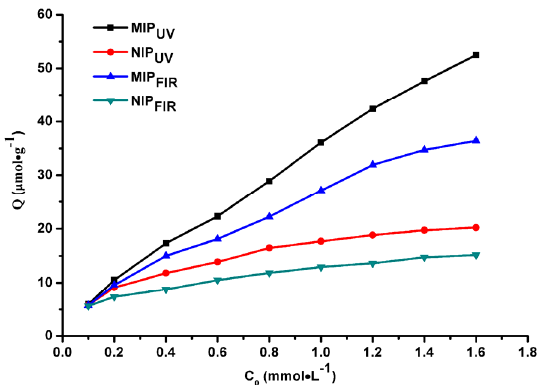
Figure 4. Comparison of equilibrium absorption obtained in separated experiments for both FIR and UV polymerization